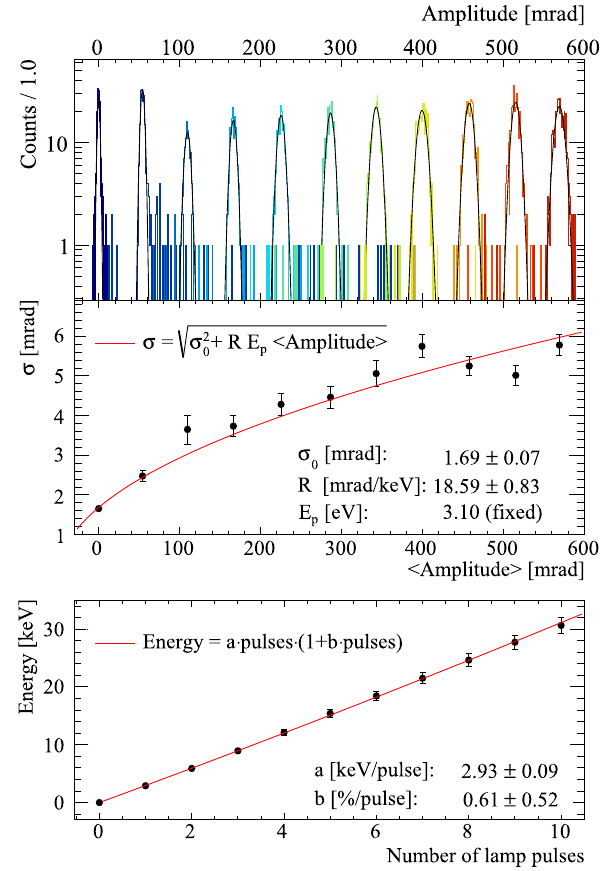
Fig. 5 Absolute energy calibration using a controlled number of fast LED pulses in order to shine increasing amounts of photons in the substrate. Top: Distribution of the amplitude of the signals after the bi- dimensional matched filter and Gaussian fits to the distributions. Mid- dle: σ oftheGaussiansasafunctionoftheirmeanvalue( < Amplitude > ) and result of the fit to Eq. (1). Bottom: Calibrated energy as a function of the number of lamp triggers. The fit function shown in the figure is used to estimate the non-linearity b of the calibration procedure and it results